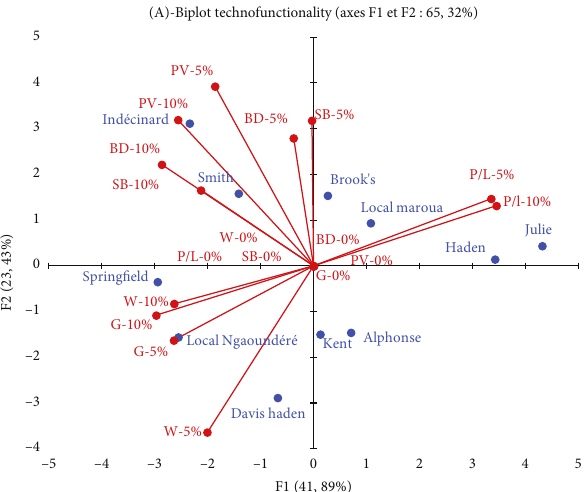
Figure 4: Variability of pasting and viscoelastic properties of almond fl ours from di ff erent mango varieties at di ff erent levels of substitution (0 – 10%) in wheat fl